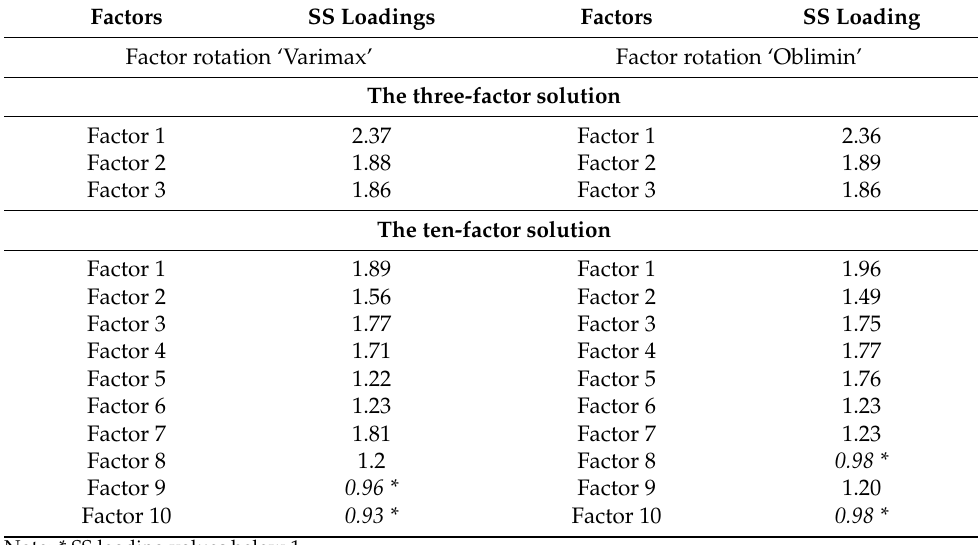
Table 4. SS loading values for individual factors.